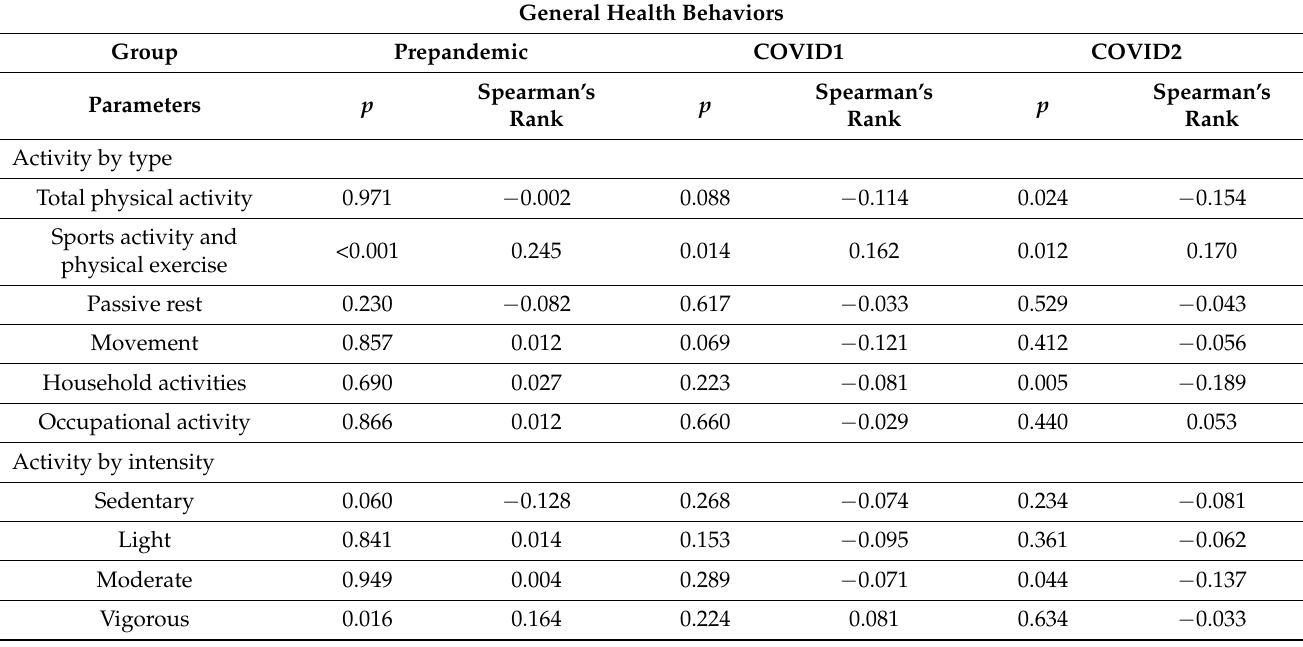
Table 4. Spearman’s Rank Correlations between general health behavior and physical activity—type of